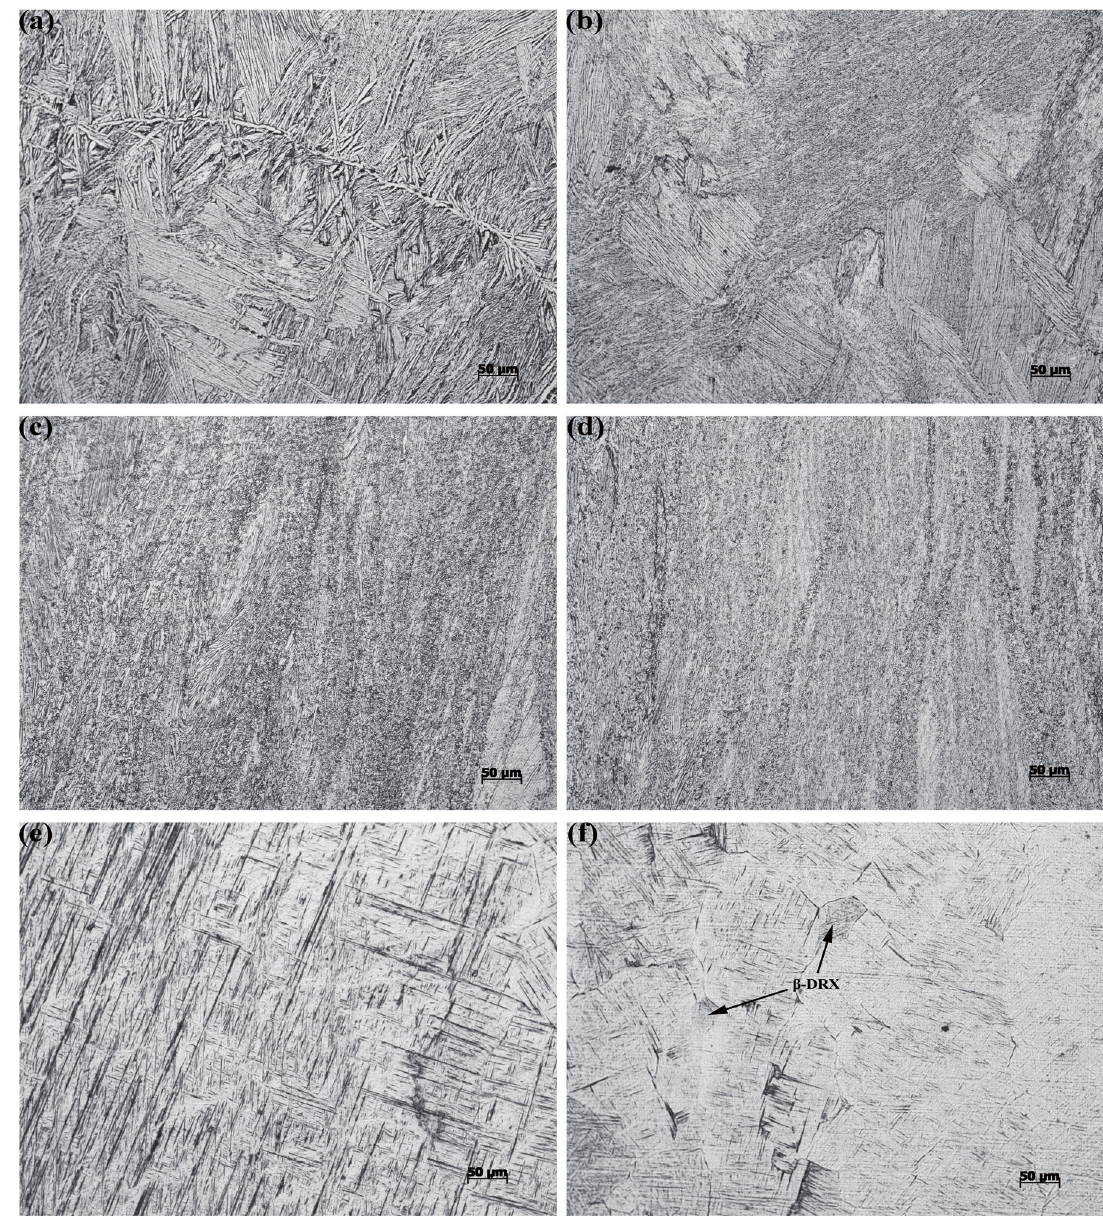
Figure 9: Microstructures of Ti-6Al-4V-0.1Ru at the strain of 0.9, strain rate of 0.01 s -1 , and deformation temperatures of (a) 1023 K; (b) 1073 K; (c) 1123 K; (d) 1173 K; (e) 1273 K and (f) 1323